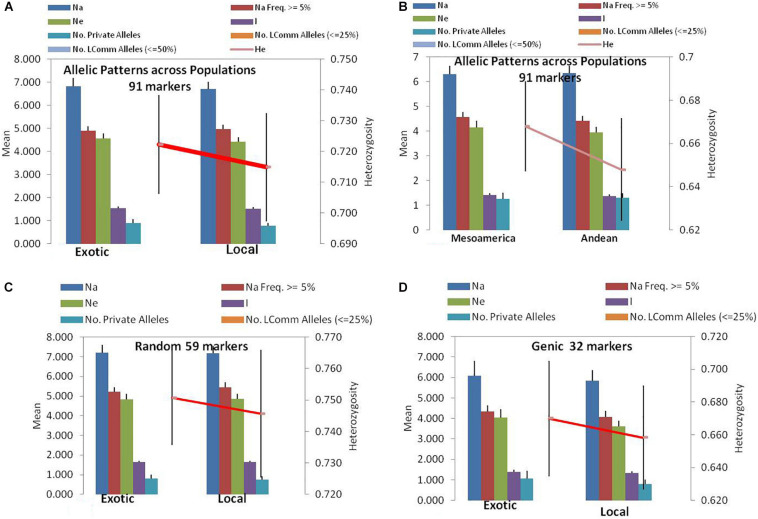
Allelic patterns in common bean by SSR markers during the present study: (A) Allelic pattern in exotic and local landraces by all 91 SSR markers. (B) Allelic pattern in Mesoamerican and Andean populations by all 91 markers. (C) Allelic pattern in exotic and local landraces by only random markers. (D) Allelic pattern in exotic and local landraces by only genic SSR markers. The red lines indicate the trend of change in diversity from one population/group to another population/group.